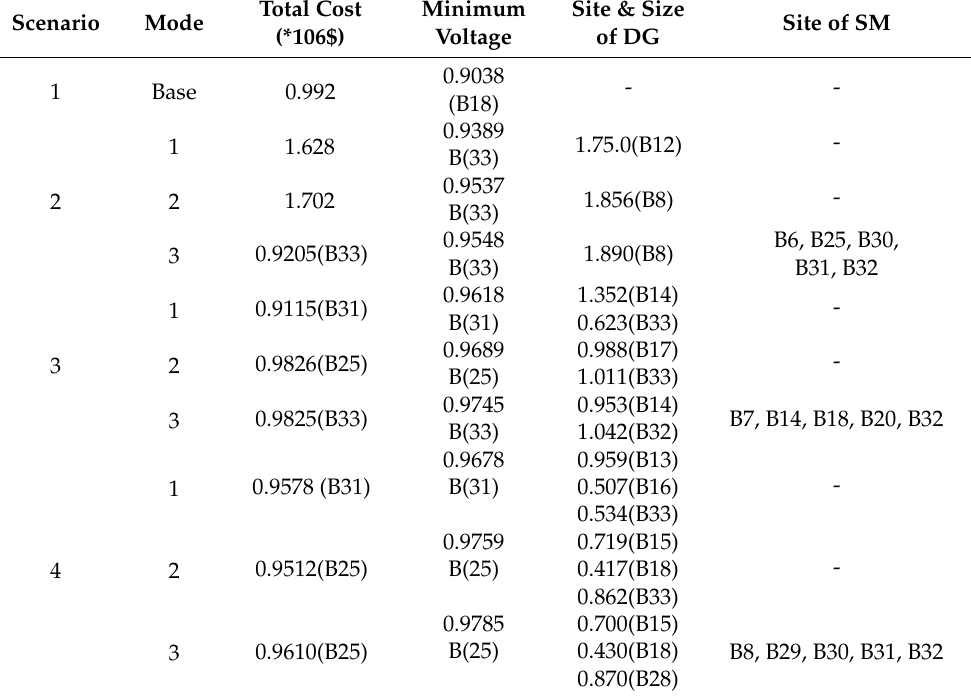
Table 4. Results in improved voltage profile function.